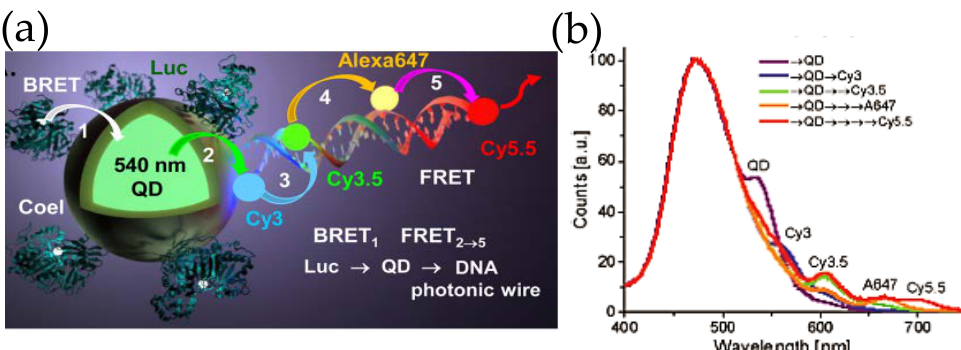
Figure 7. ( a ) Schematic depicting a self-assembled DNA photonic wire built onto QD–Luc conjugates. ( b ) The photonic wire, which was synthesized by hybridizing small fragments of DNA with pendant fluorescent organic dyes allows spatial and spectral propagation of excitonic energy via sequential FRET as displayed in the plot. The ratiometric self-assembly of Luc and the DNA wire, that relies upon His 6 -Zn 2 + coordination chemistry, provides control over energy transfer efficiency. Reprinted with permission from [59]. Copyright 2015 American Chemical Society.